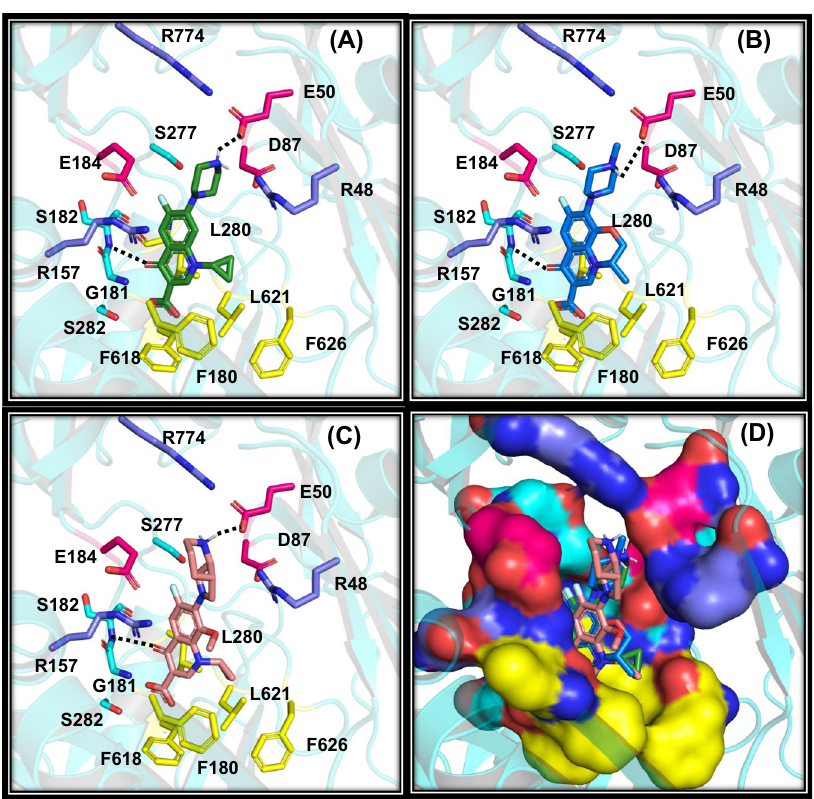
Fig. 5 Predicted binding modes of fl uoroquinolones with OqxB. Molecular docking predicted binding orientations of cipro fl oxacin ( A ), levo fl oxacin ( B ), and moxi fl oxacin ( C ). Hydrophobic, positively charged, negatively charged residues depicted as yellow, blue, and magenta sticks, respectively. Other important substrate-binding pocket residues are shown as cyan color sticks. Inter-molecular hydrogen bond interactions are highlighted with broken lines. All the predicted docking modes are superposed to illustrate similar interaction patterns of fl uroquinolones with OqxB substrate-binding pocket ( D